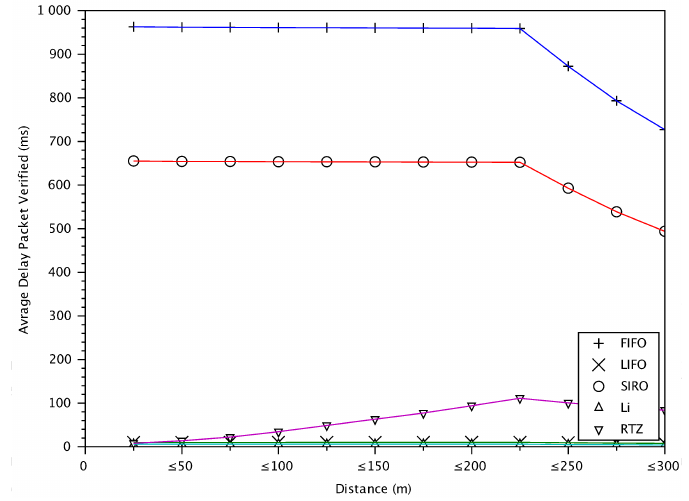
Figure 11. Average delay of verified messages versus distances between transmitting and receiving